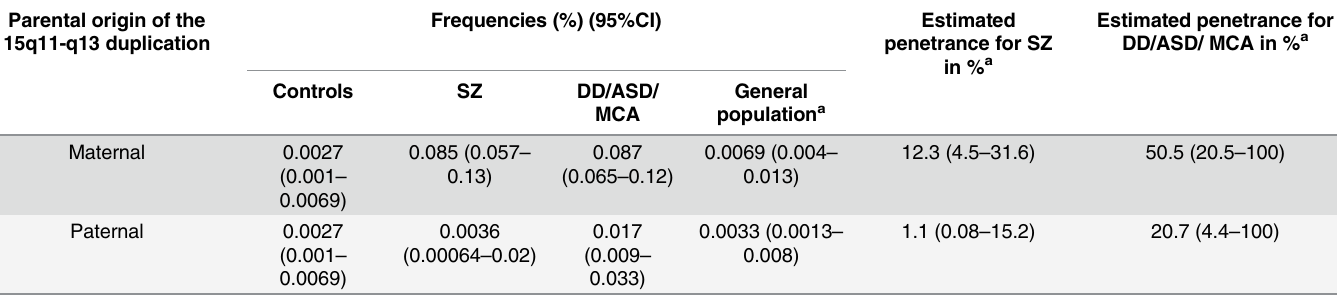
a Details for the methods used to calculate these estimates are presented in the Methods